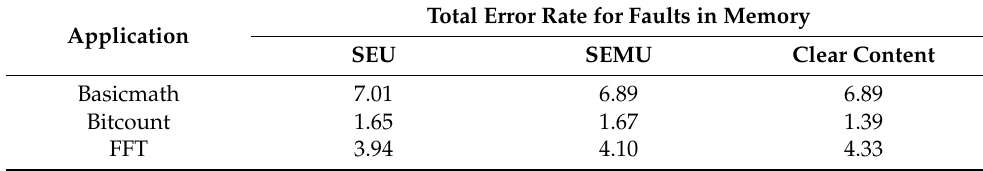
Table 1. Error rate classified per application and fault model in